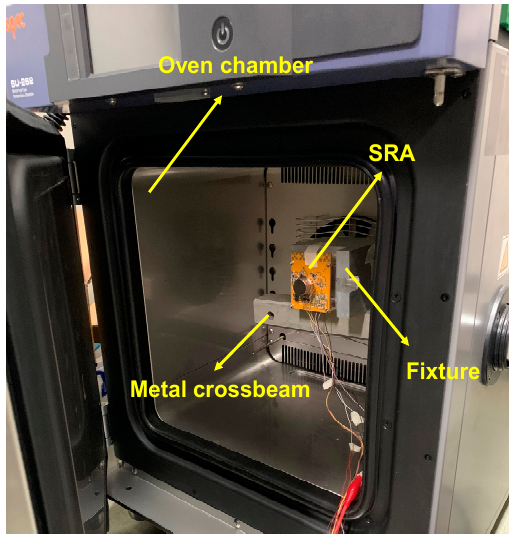
Figure 12. The SRA is put inside an oven chamber for temperature performance testing.